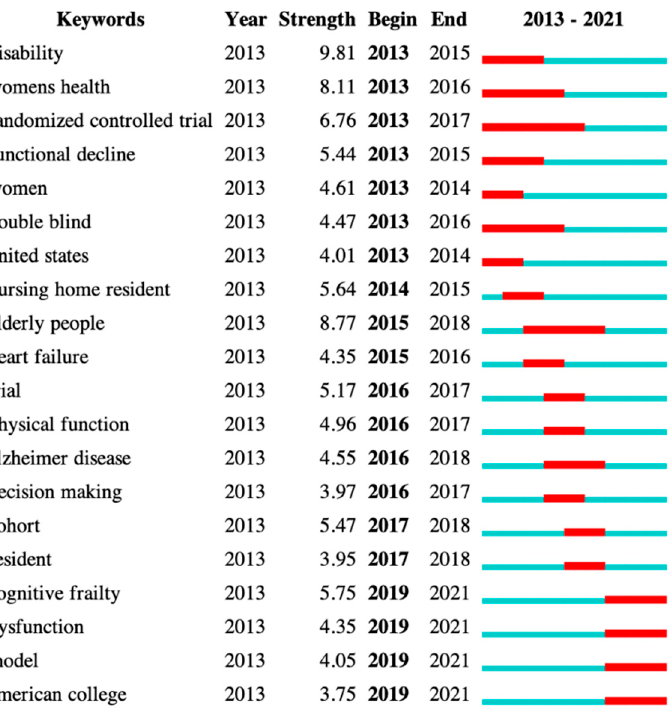
Figure 7. 20 keywords with the strongest citation burst. “Disability” shows the highest burst strength, while “cognitive frailty”, “dysfunction”, “model”, and “American college” were the most recent citation bursts.